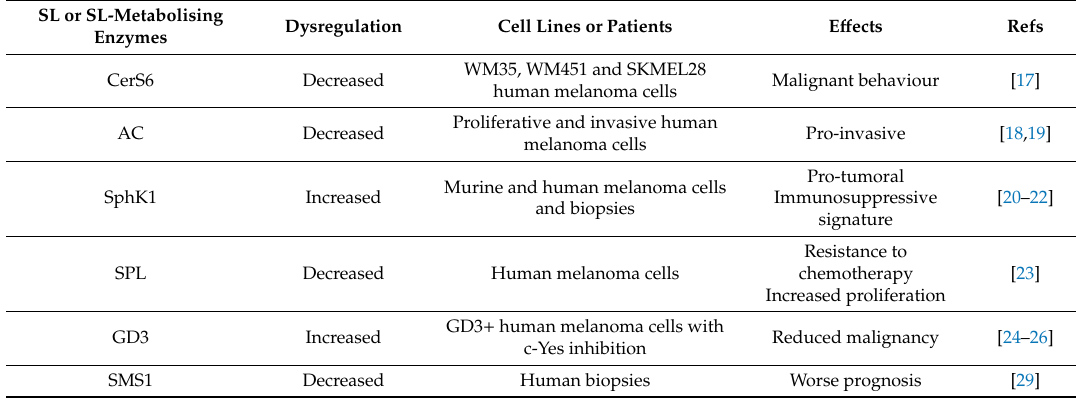
Table 1. Impact of SL and SL-metabolising enzymes dysregulations on melanoma cell lines and patients. SL or SL-Metabolising